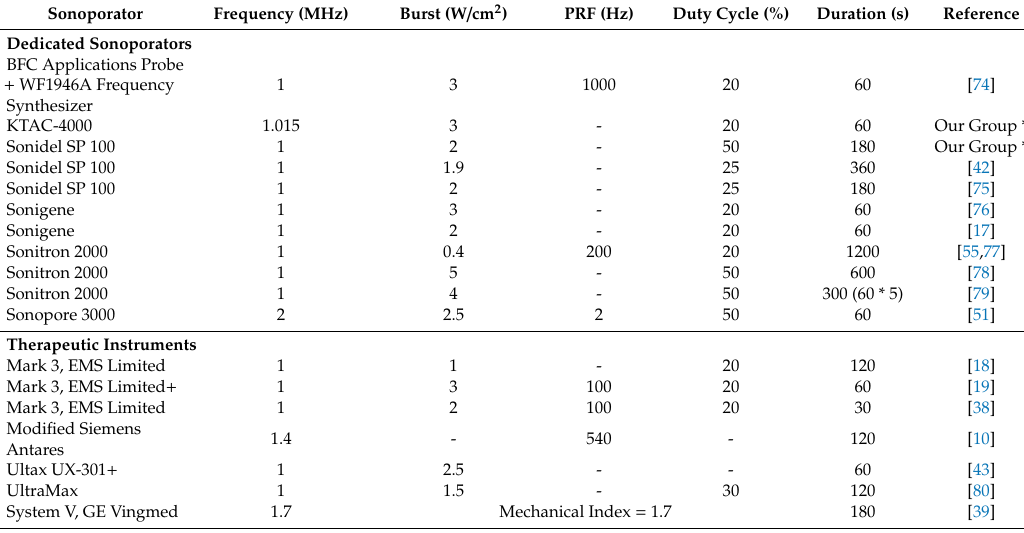
Table2. Examplesofoptimizedin vivosonoporationconditions. Theconditionslistedarerepresentative of the preferred conditions for pDNA delivery in the referenced experiment; they are not representative of all conditions tested. PRF = pulse repetition frequency; “-“ = not reported; * = unpublished data; + = not listed in work, but based on work carried out by same reference